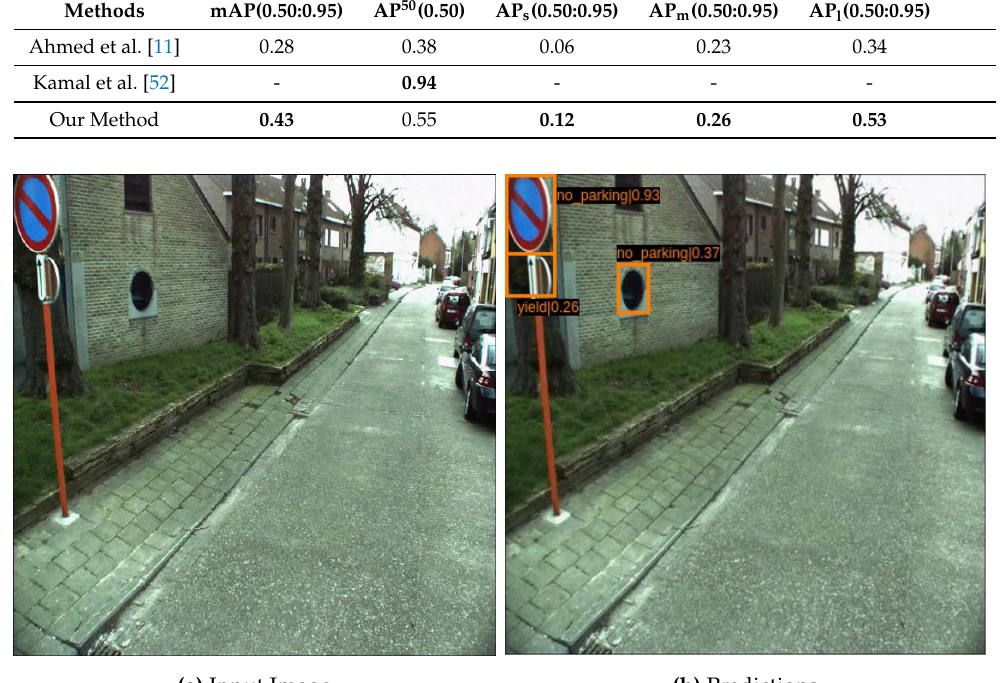
Figure 9. Example of results achieved on the CURE-TSD Dataset. ( a ) represents an input image, whereas ( b ) is the final output with the detected object. The blue color represents ground truth annotation, and orange is the network